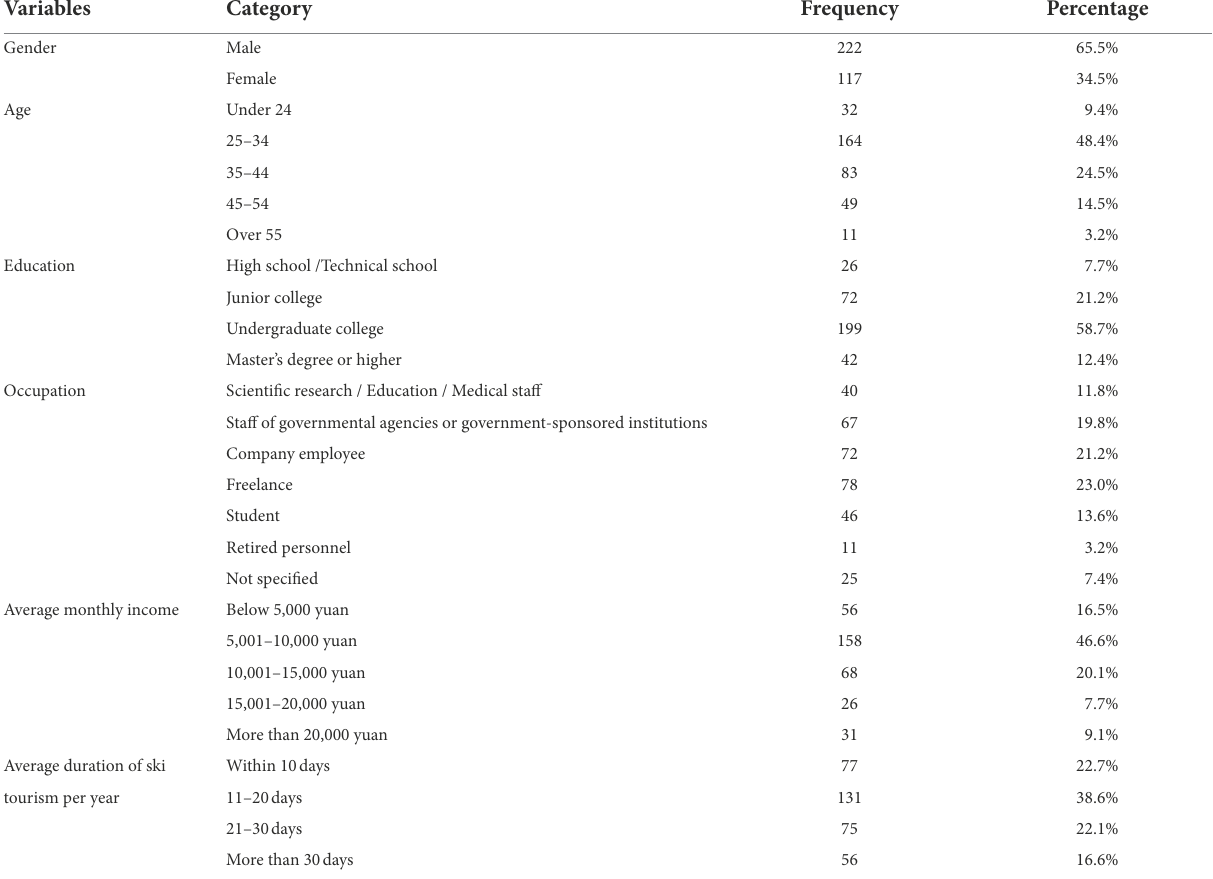
TABLE 2 Demographic profile of the respondents ( N =